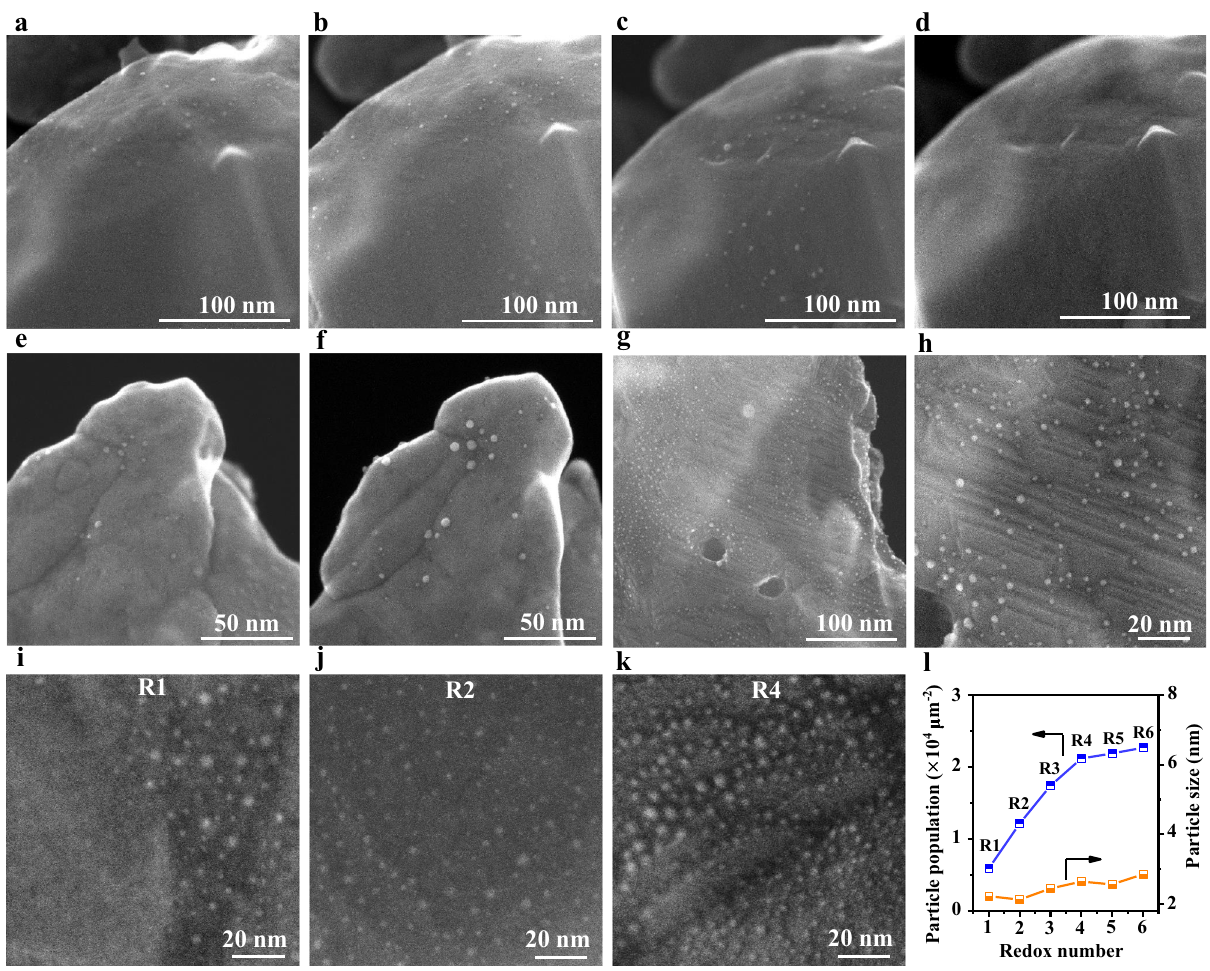
Fig. 1 Morphological study of the SFRuM catalysts. In situ secondary electron (SE)-STEM images of SFRuM after reduction at 800 °C for ~15 min ( a ), after reduction at 800 °C for ~30 min ( b ), after reoxidation at 800 °C for ~30 min ( c ), and after reoxidation at 800 °C for ~40 min ( d ). In situ SE-STEM images of SFRuM O1 after reduction at 600 °C for ~10 min ( e ), after reduction at 800 °C for ~10 min ( f ), and after reduction at 800 °C for ~60 min ( g ). h Magni fi ed image of ( g ). Ex situ SE-STEM images of SFRuM R1 ( i ), SFRuM R2 ( j ), and SFRuM R4 ( k ). l Population and size distribution of metal NPs exsolved after different redox